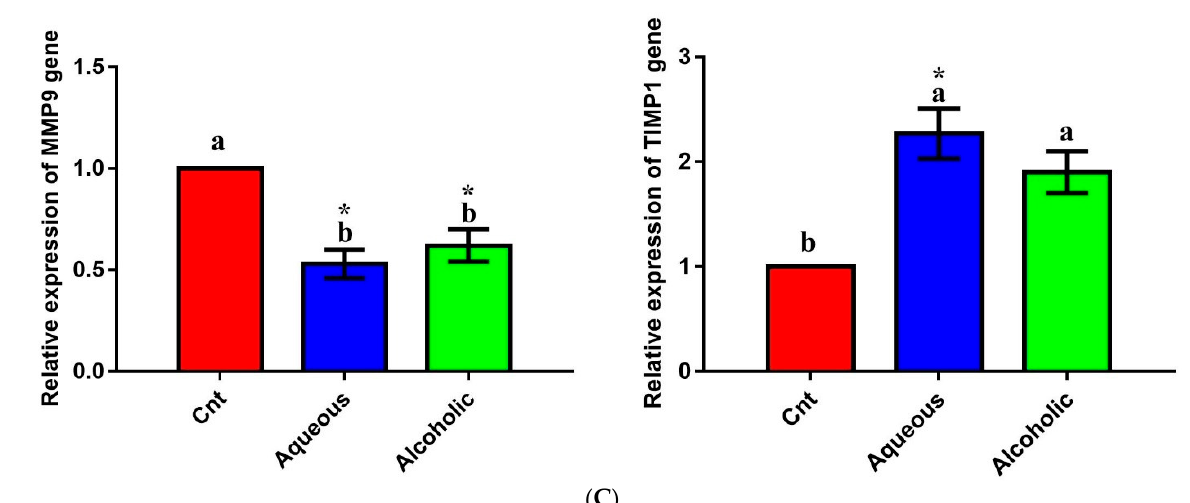
Figure 7. Anti-migratory effect of 5% aqueous and alcoholic larval extracts on MCF7 cells. ( A ) Wound-healing assay. ( B ) Percentage of wound closure of MCF7 cells. ( C ) Expression of MMP9 and TIMP1 genes in MCF7 cells. Data are expressed as the mean ± SEM. Samples were run in triplicate in three independent experiments, n = 5. Groups with different letters are significantly different at p < 0.05. * indicates high significance with respect to the control ( p < 0.01).